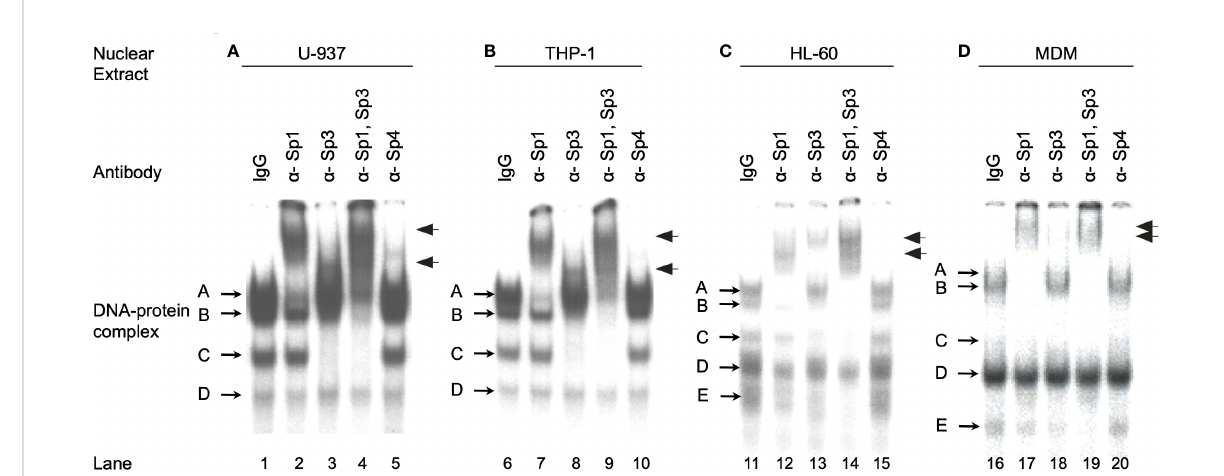
FIGURE 2 Monocytic Sp TFs bind a high af fi nity HIV-1 Sp binding site. EMS analyses using the HIV-1 subtype B consensus Sp site III were performed as described in the Materials and Methods. Binding reactions included 6 m g of U-937 (A) , THP-1 (B) , or HL-60 (C) nuclear extract with 60,000 cpm radiolabled probe (approximately 1 ng). MDM nuclear extract (20 m g) (D) was also reacted with 60,000 cpm of radiolabled probe. Antisera (1 m l) was added as indicated. DNA-protein complexes are labeled A through E, while supershifted DNA-protein complexes are indicated with